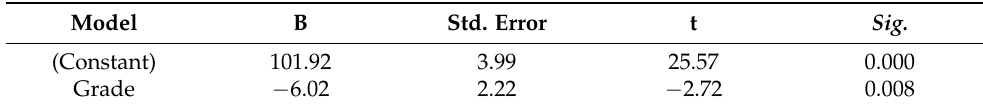
Table 4. Linear regression model with predictor “grade” for performance status at the 4th timepoint assessment